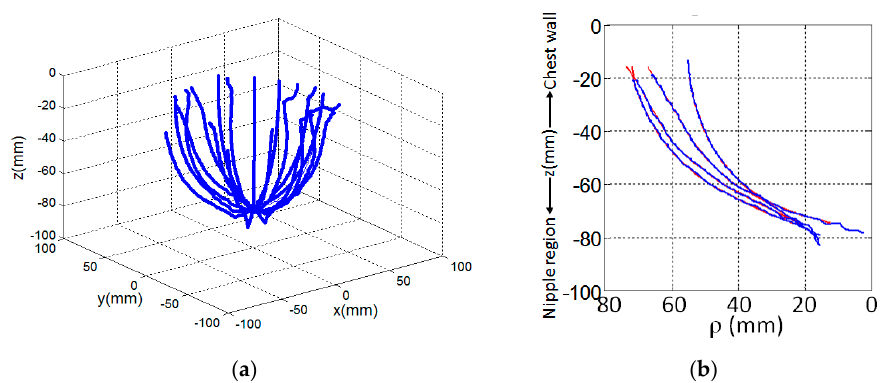
Figure 2. ( a ) Surface samples acquired dynamically over profile by laser as it moves vertically from chest wall to nipple region at a given azimuth. Process repeated over equally spaced azimuths. ( b ) Breast profile estimated (red) from these measured data (blue) at four different azimuth angles of a patient. An extrapolation of the profile is shown near the chest wall.